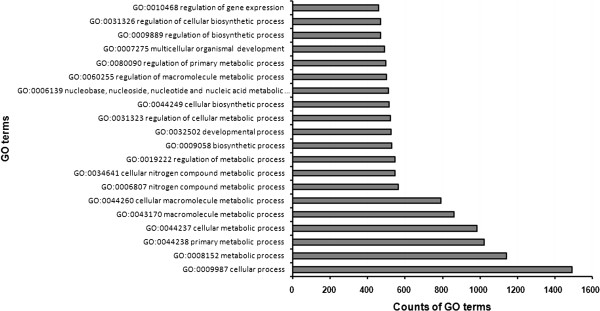
Enriched GO terms in the biological process category among differentially expressed miRNAs. After miRNA microarray assay, significantly enriched GO analysis in the biological process category was performed on differentially expressed genes in the brains of RABV-infected mice using DAVID (P < 0.01). Only the top twenty GO terms are listed here. For other enriched GO terms, please see Additional file
1: Table S1.